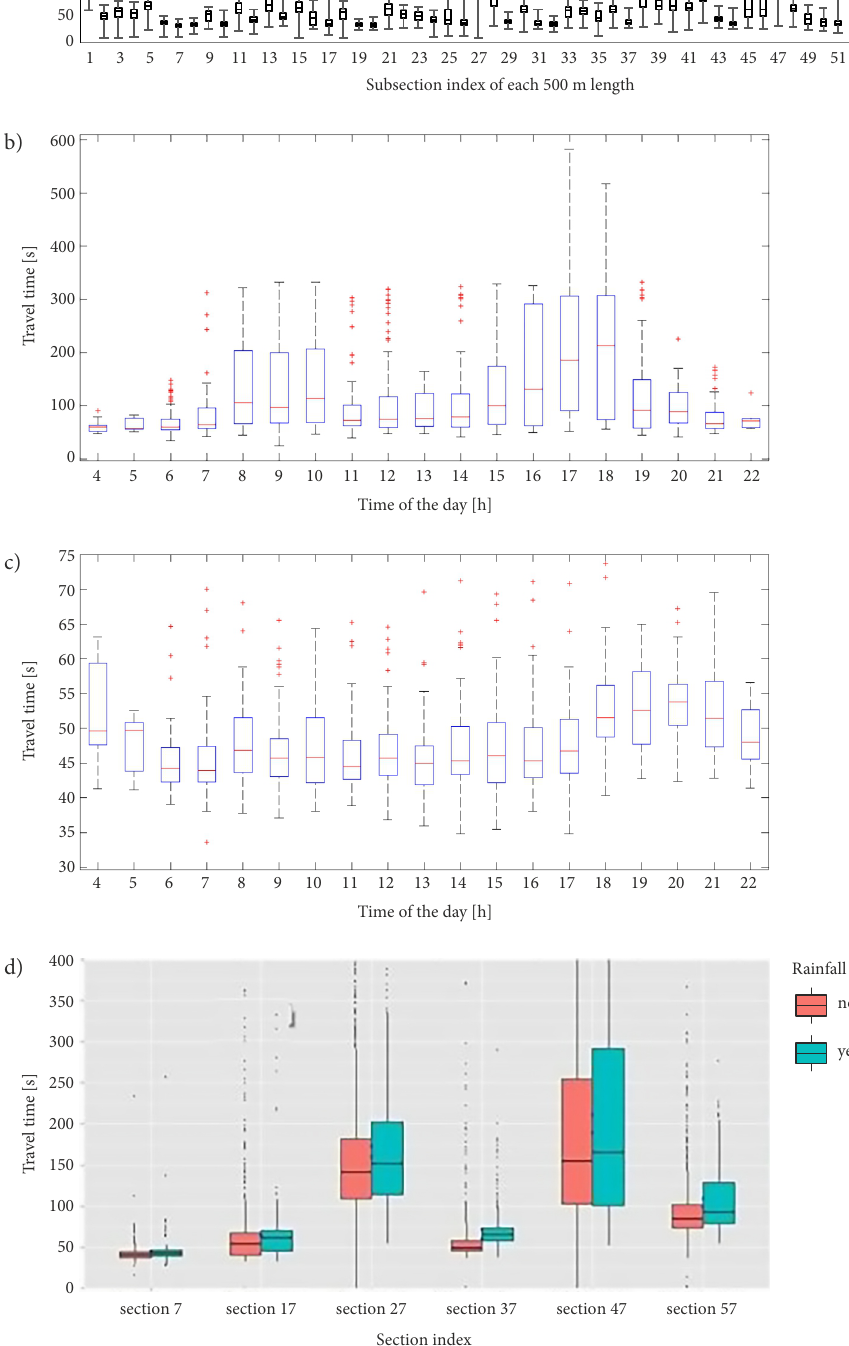
Figure 2. Variations: a – variation in travel time across various sections along the route; b – travel time variation in subsection 46 (urban); c – travel time variation in subsection 7 (suburban); d – effect of rainfall on bus travel time for sample